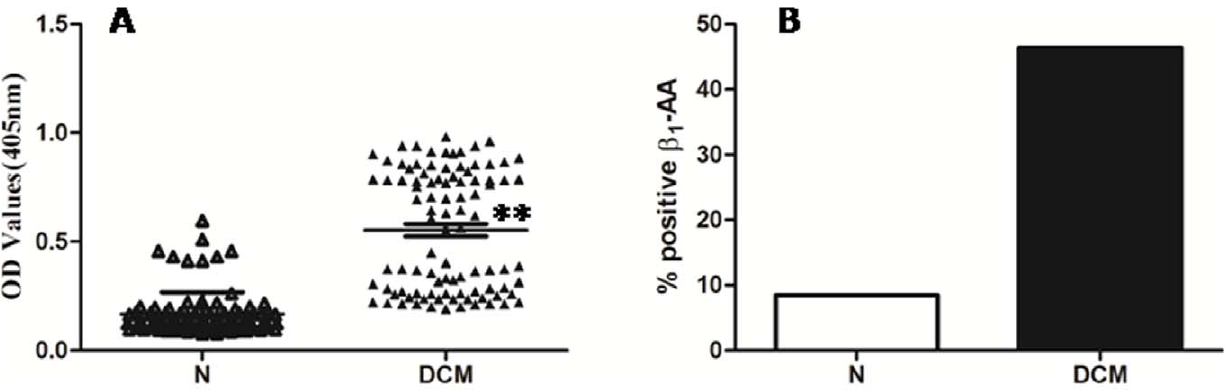
Figure 1. Titers and incidence of b 1 -AA in 95 healthy subjects and 95 patients with DCM. A. Titers of b 1 -AA from 95 healthy subjects ( open squares ) and 95 patients with DCM ( filled squares ). Scatter plot represents the titers of b 1 -AA for each patient in each group. Experiments were repeated twice per sample. B. Percentage of b 1 -AA-positive sera from two different groups. N, normal group, DCM dilated cardiomyopathy. ** p , 0.01 versus N group.